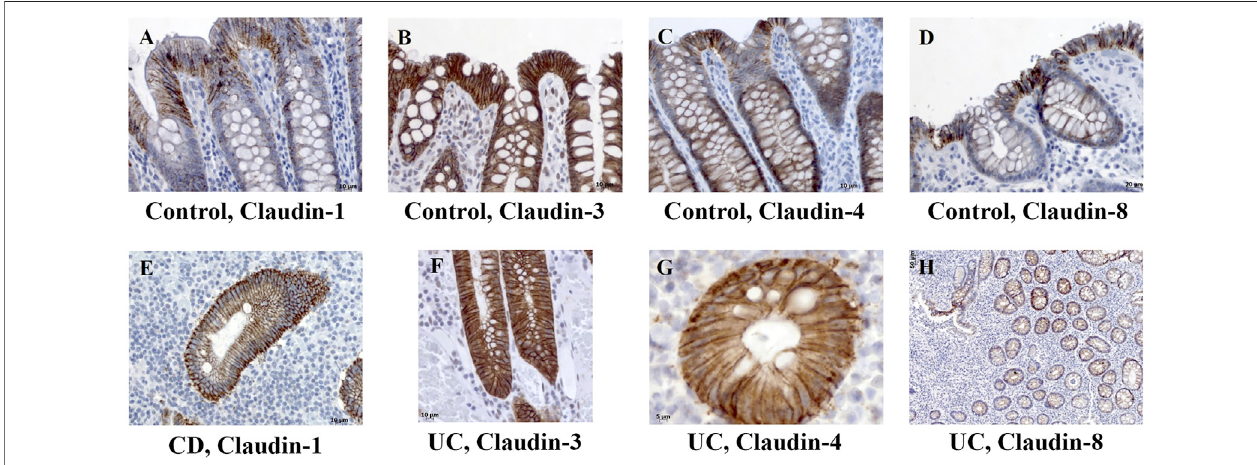
FIGURE 2 | Claudin-1, claudin-3, claudin-4, and claudin-8 expression patterns of absorptive cells in control human colon and colon of IBD patients. (A) Claudin - 1 (IHC), control human colon; (B) claudin-3 (IHC), control human colon; (C) claudin-4 (IHC), control human colon; (D) claudin - 8 (IHC), control human colon; (E) claudin-1